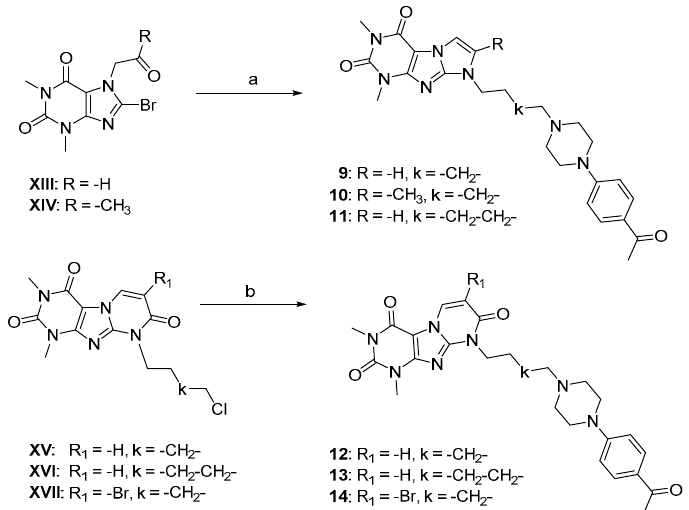
Table 1. Cytotoxic activity IC 50 (µM) of compounds 1 – 14 was estimated by the MTT assay. Data are expressed as the mean ± SD.